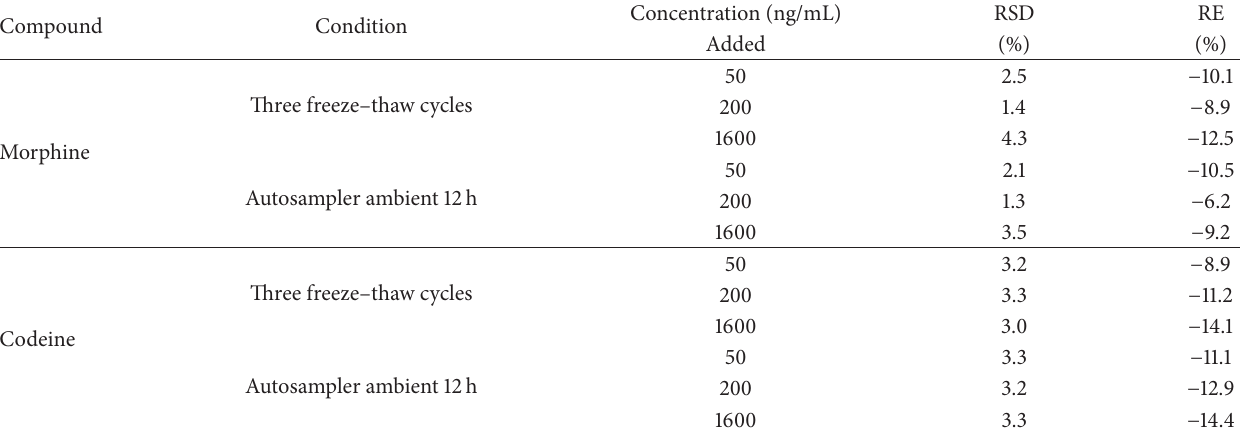
Table 2: Summary of stability of morphine and codeine under various storage conditions (𝑛 = 3) . Compound